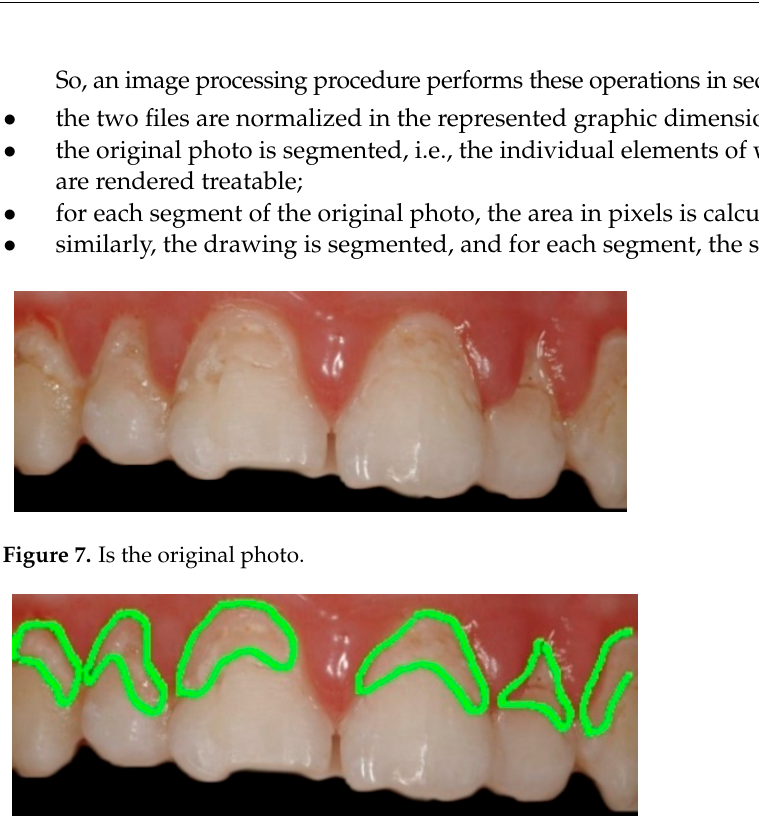
Figure 8. Shows the original image with the traced contours of the erosion area.